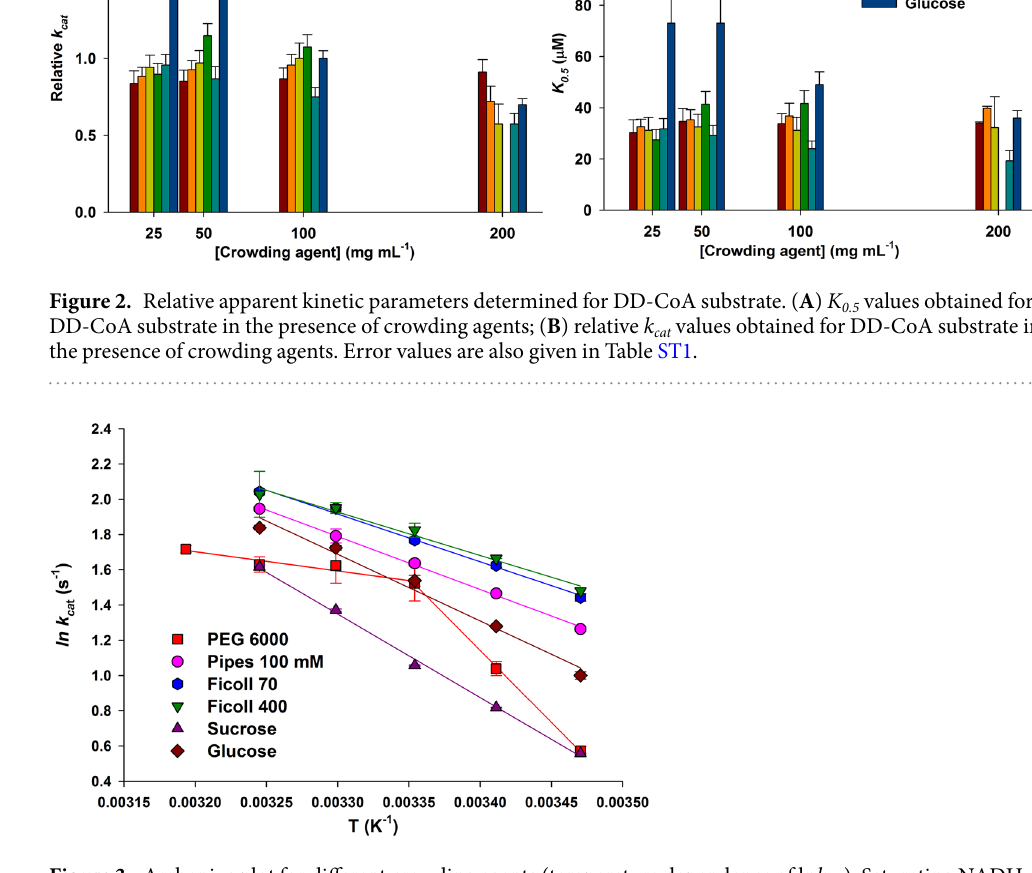
Table 1. Thermodynamic activation parameters for InhA. a Crowding agents at 200 mg mL − 1 . b Values determined at 25 °C (298.15 K).